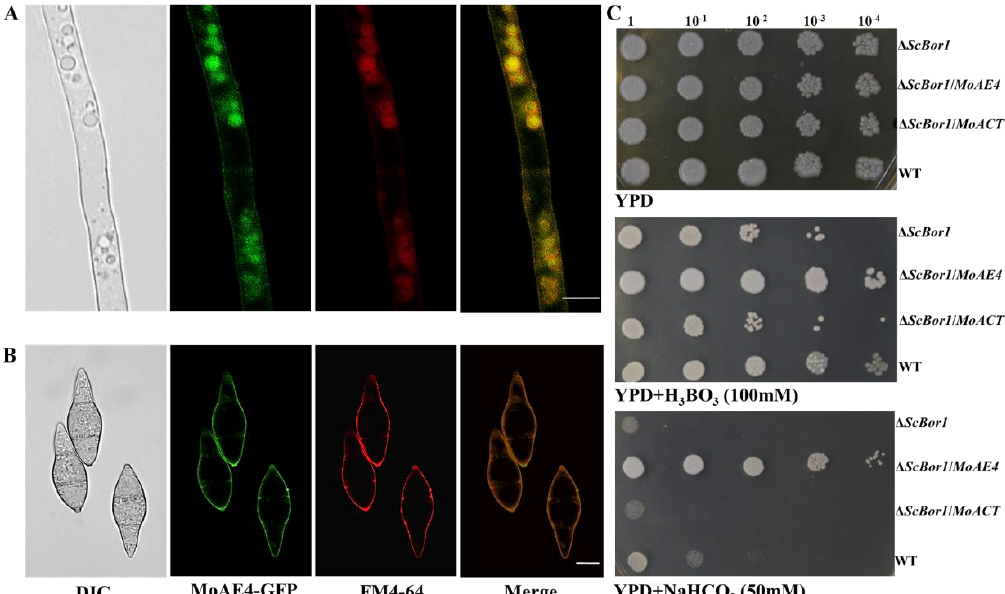
Figure 2. MoAE4 subcellular localization and functions in yeast. ( A ) Subcellular localization in hyphae (6d). Green fluorescence signals of the MoAE4–GFP protein of 6–day–old hyphae was examined by confocal microscopy and co–localized with FM4–64 on cytomembrane and tonoplast. Scale bar = 10 µm. ( B ) Subcellular localization in conidia. A strong green fluorescence signal of the MoAE4–GFP protein co–localized with FM4–64 red fluorescence was detected on the cytoplasmic membrane in conidia. Scale bar = 10 µm. ( C ) Functional complementation of MoAE4 for ScBor1 in S. cerevisiae . In total, 10 μL droplets containing the indicated concentration of yeast cells were inoculated on to the Solid YPD medium Plates (100 mM H 3 BO 3 and 50 mM NaHCO 3 added, respectively). The MoAE4 gene could functionally reverse the defect of the Δ ScBor1 mutant in boric acid and NaHCO 3 tolerance. Representative plates were photographed 3 days post-inoculation.